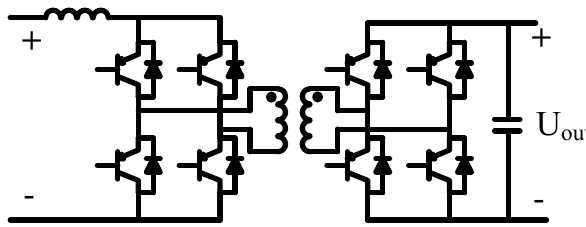
Figure 10. Topology of isolated full-bridge bidirectional DC/DC converter.